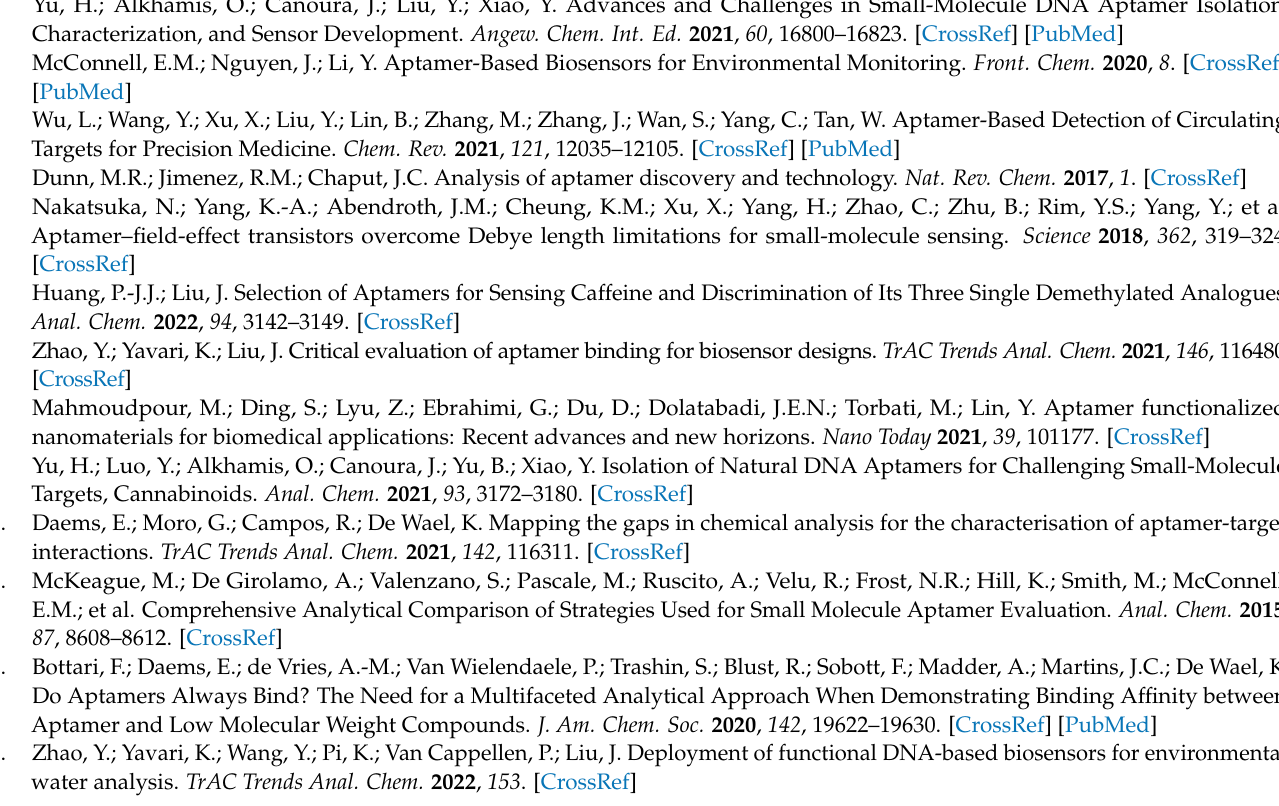
Figure S2: The fluorescence emission spectrum of different DNA excited at different wavelength; Figure S3: Fluorescence of glucose and quinine aptamer upon titration of cortisol; Figure S4: The fluorescence emission spectrum of SYBR Green I after adding T30 and Hg 2+ ; Figure S5: UV-vis spectra of adenosine; Figure S6: The fluorescence emission spectrum of adenosine; Figure S7: The fluorescence emission spectrum of the adenosine aptamer upon titration of adenosine; Figure S8: The fluorescence emission spectrum of ThT after adding 3bp and 2bp adenosine aptamer and different concentration of adenosine; Figure S9: The fluorescence emission spectrum of caffeine; Figure S10: The fluorescence emission spectra of the caffeine aptamer upon titration of caffeine; Figure S11: Fluorescence of the 1bp, 2bp and 4bp aptamer upon titration of